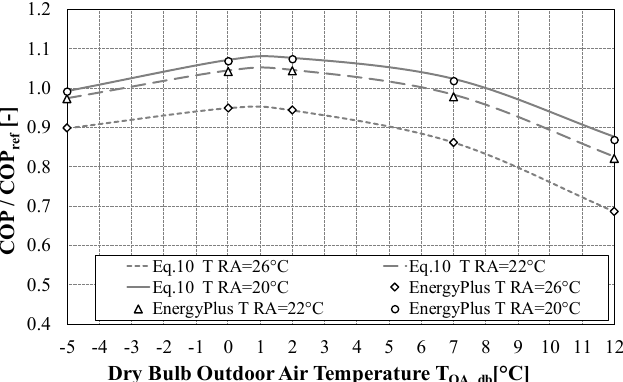
Figure 8. EIR in cooling mode: comparison between EnergyPlus simulations and Equation (8) with Table 6 coefficients.